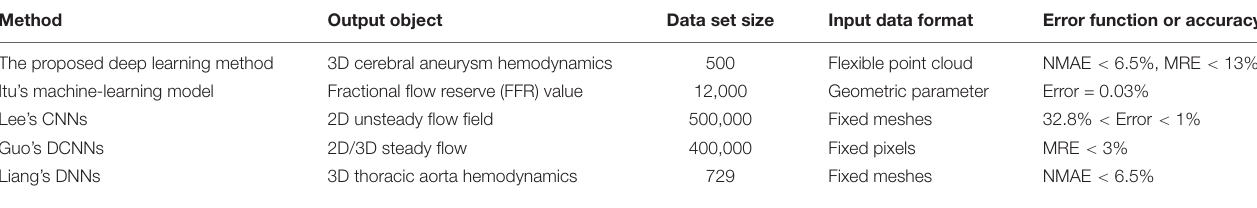
TABLE 4 | Flow or hemodynamics prediction accuracy reported by other machine or deep learning